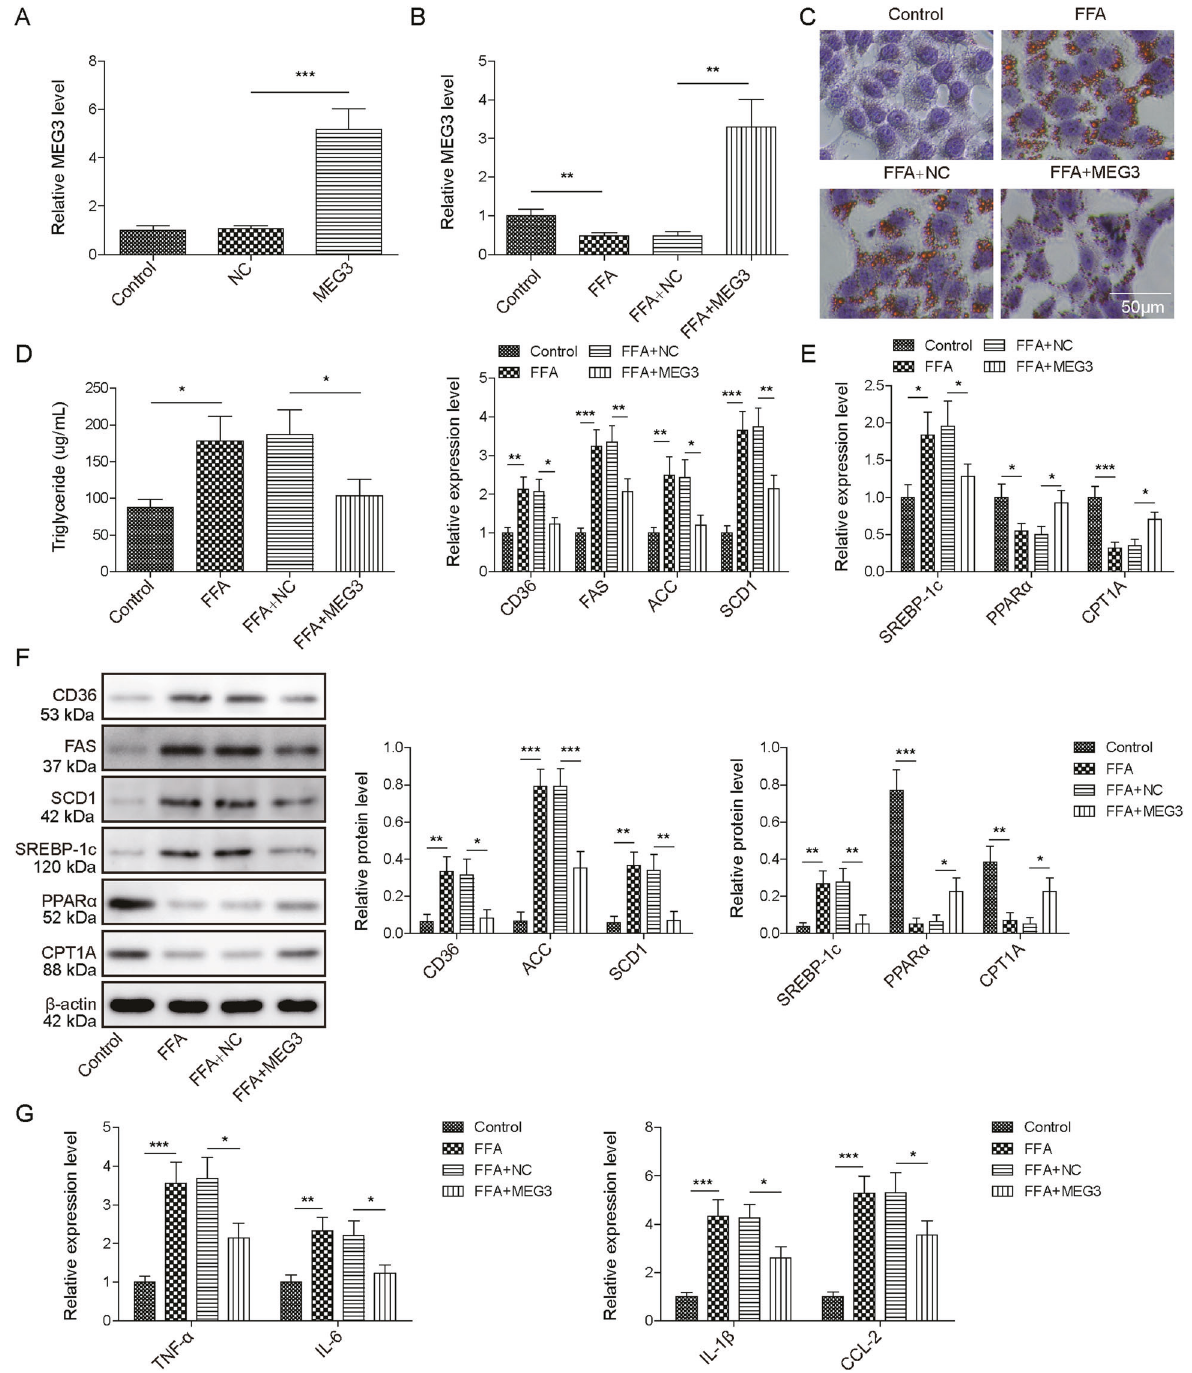
Fig. 2 Overexpressing MEG3 protected hepatocytes from FFA challenge. A Transfection of hepatocytes with MEG3-expressing vector (MEG3) signi fi cantly increased MEG3 level. Non-transfected (control) and those transfected with empty vector (NC) were used as negative controls. B MEG3 expression was examined by RT-qPCR in indicated hepatocytes. Oil Red O staining ( C ), triglyceride content ( D ), expressions of indicated genes involved in lipid metabolism on mRNA ( E ) and protein ( F ) levels, and expressions of pro-in fl ammatory TNF- α , IL-6, IL-1 β , and CCL2 ( G ) were examined in indicated hepatocytes. * P < 0.05, ** P < 0.01, *** P <